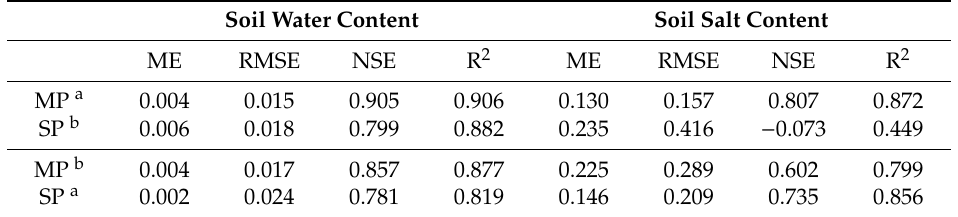
MP: soil samples at middle position of soil profile perpendicular to the SDM. SP: soil samples at side position of soil profile perpendicular to the SDM. a means the data for calibration. b means the data for validation.